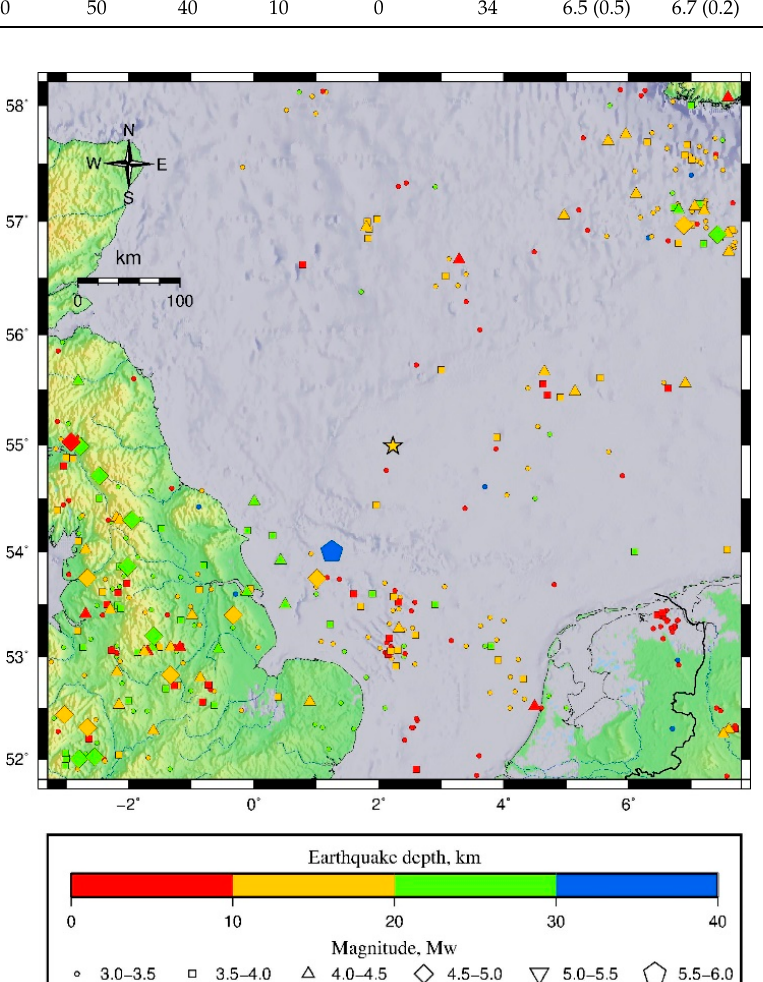
Figure 3. Merged earthquake catalogue with magnitude conversion to moment magnitude according to NRC [35]. The yellow star indicates the center of the wind farm